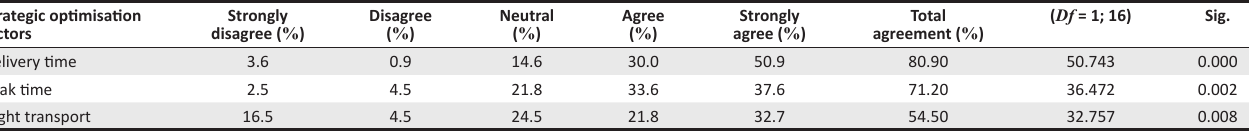
TABLE 2a: Strategic optimisation factors. Strategic optimisation factors